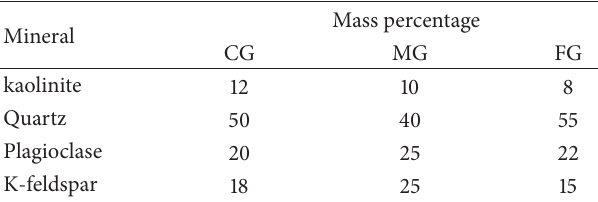
Table 2: Mineral compositions of the three types of sandstone.